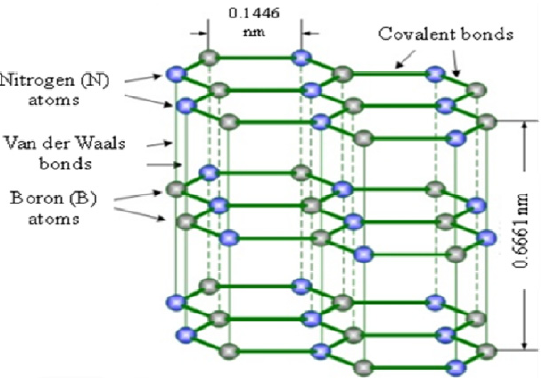
Figure 1. h-BN stacked structure (the image is reproduced from [40], copyright 2012, with permission from SPIE).